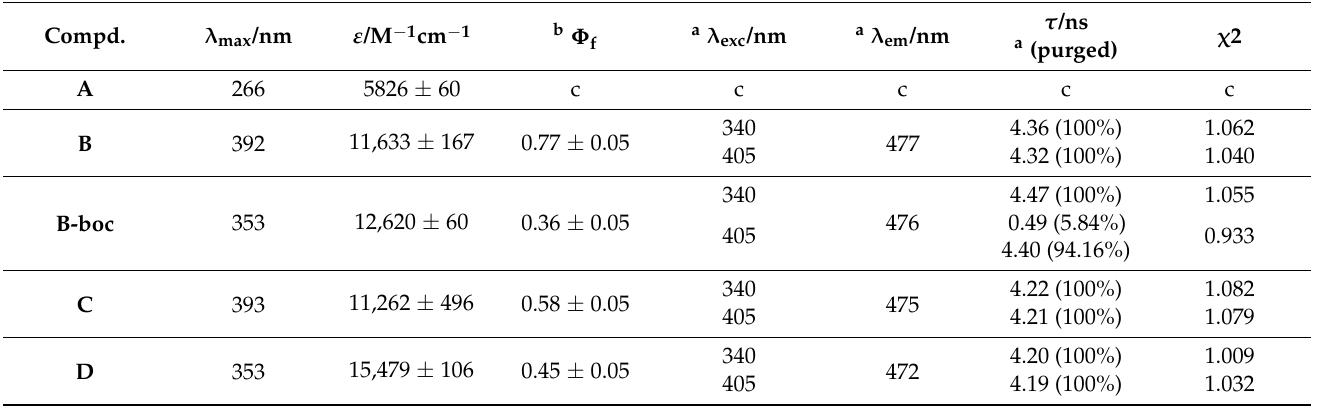
Table 1. Electronic absorption and emission data of B , B-boc , C and D at pH 7, sodium cacodylate buffer, c = 50